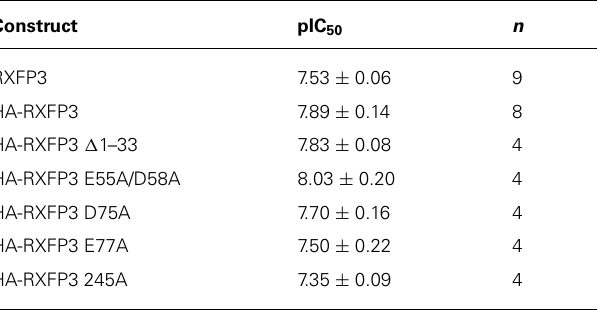
Table 3 | Competition binding results for HA-RXFP3 mutants.